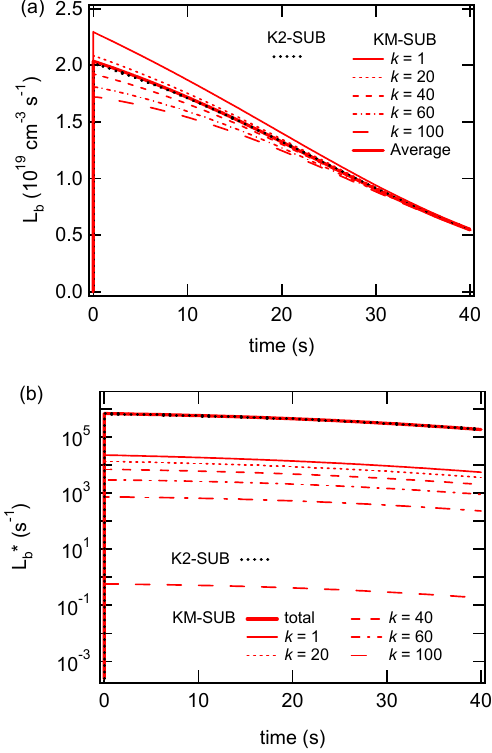
Fig. 7. (a) Loss rate ( L b ) and (b) absolute loss rate ( L ∗ ) of oleic b k 36 acid in the bulk calculated by KM-SUB for bulk layers 1 (near- surface bulk), 20, 40, 60, and 100 (core) in BC2. L b calculated /V b ) calculated by KM- by K2-SUB and volume average L b ( = L ∗ b ) calculated SUB are shown in panel (a). Total absolute los rate ( L ∗ b by KM-SUB and K2-SUB are also shown in panel . b